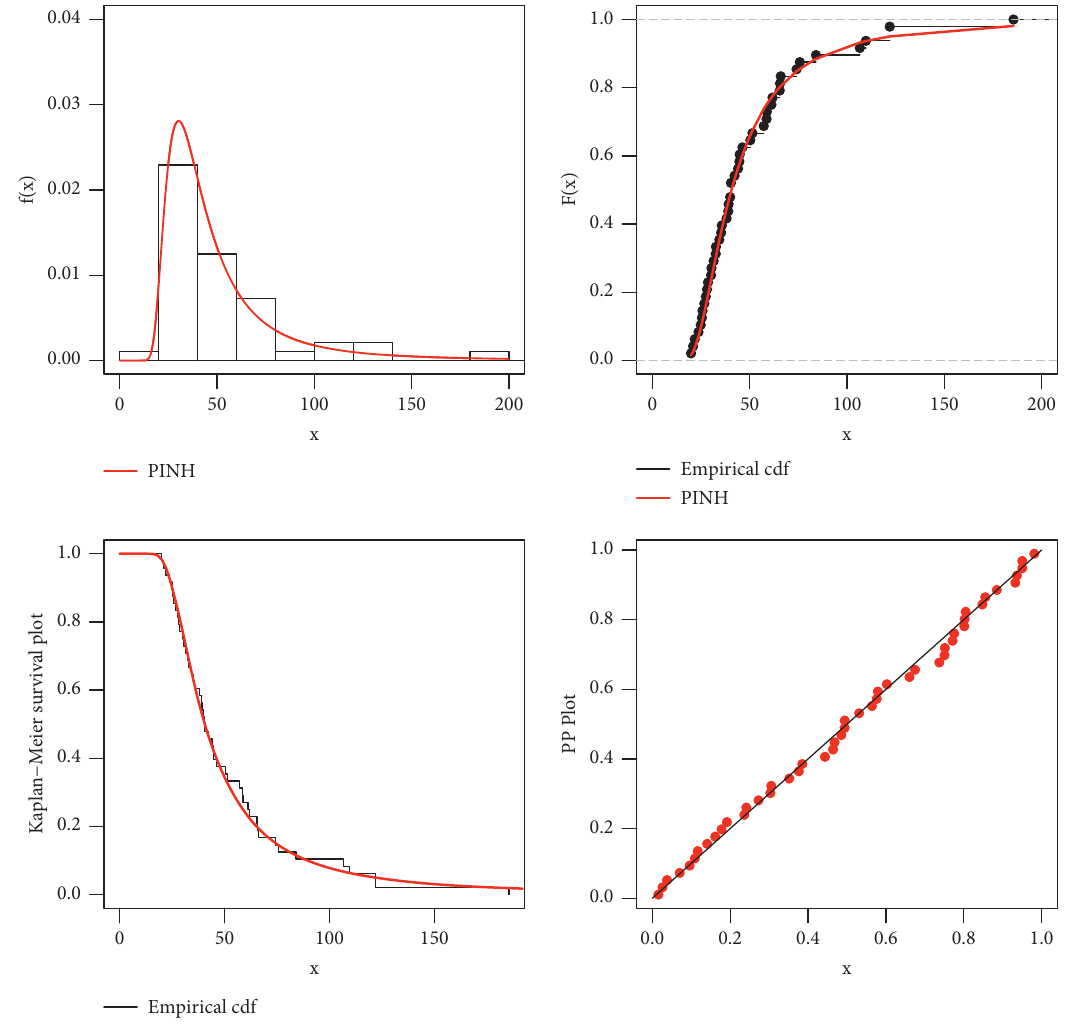
Figure 3: Fitted probability models and empirical data for first data